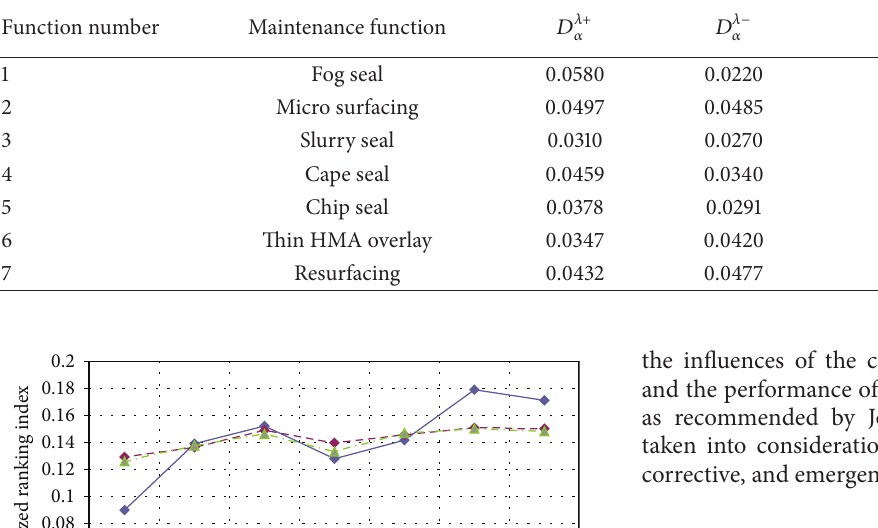
Table 12: Maintenance function ranking and performance index ranking using fuzzy TOPSIS.